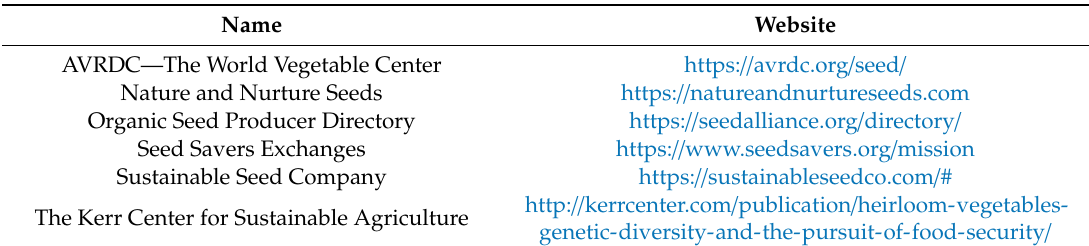
Table 1. Some gene banks or seed-saver organizations providing heirloom cultivars or related